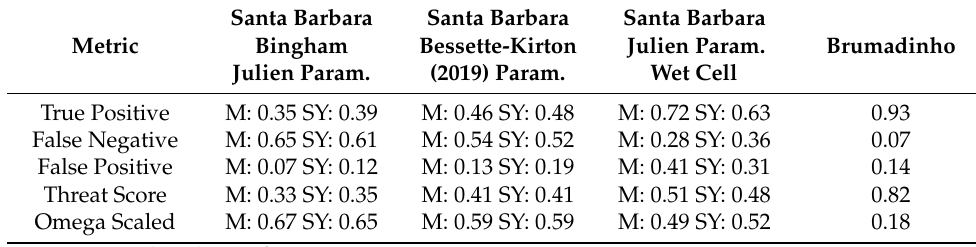
Table 2. Mudplain area